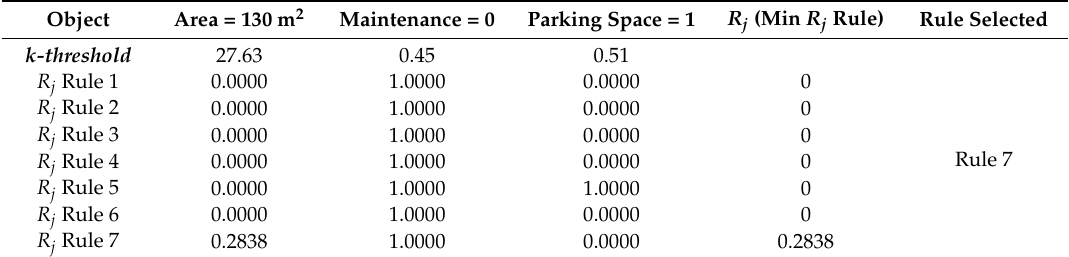
Table 10. Results of Rough Set Theory integrated with Value Tolerance